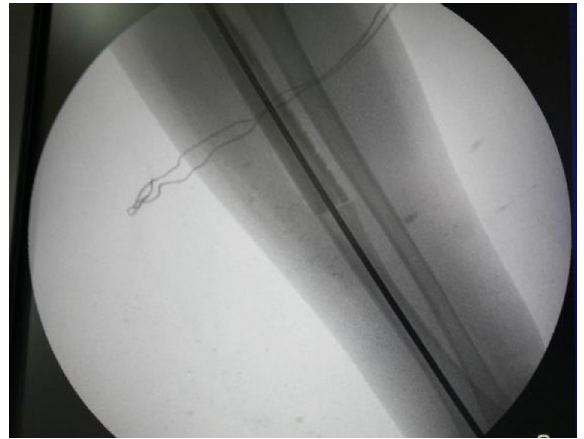
Figure 5. Intraoperative roentgenograph showing reconstruction of the radius using maternal fibular graft fixed with an intramedullary K-wire.